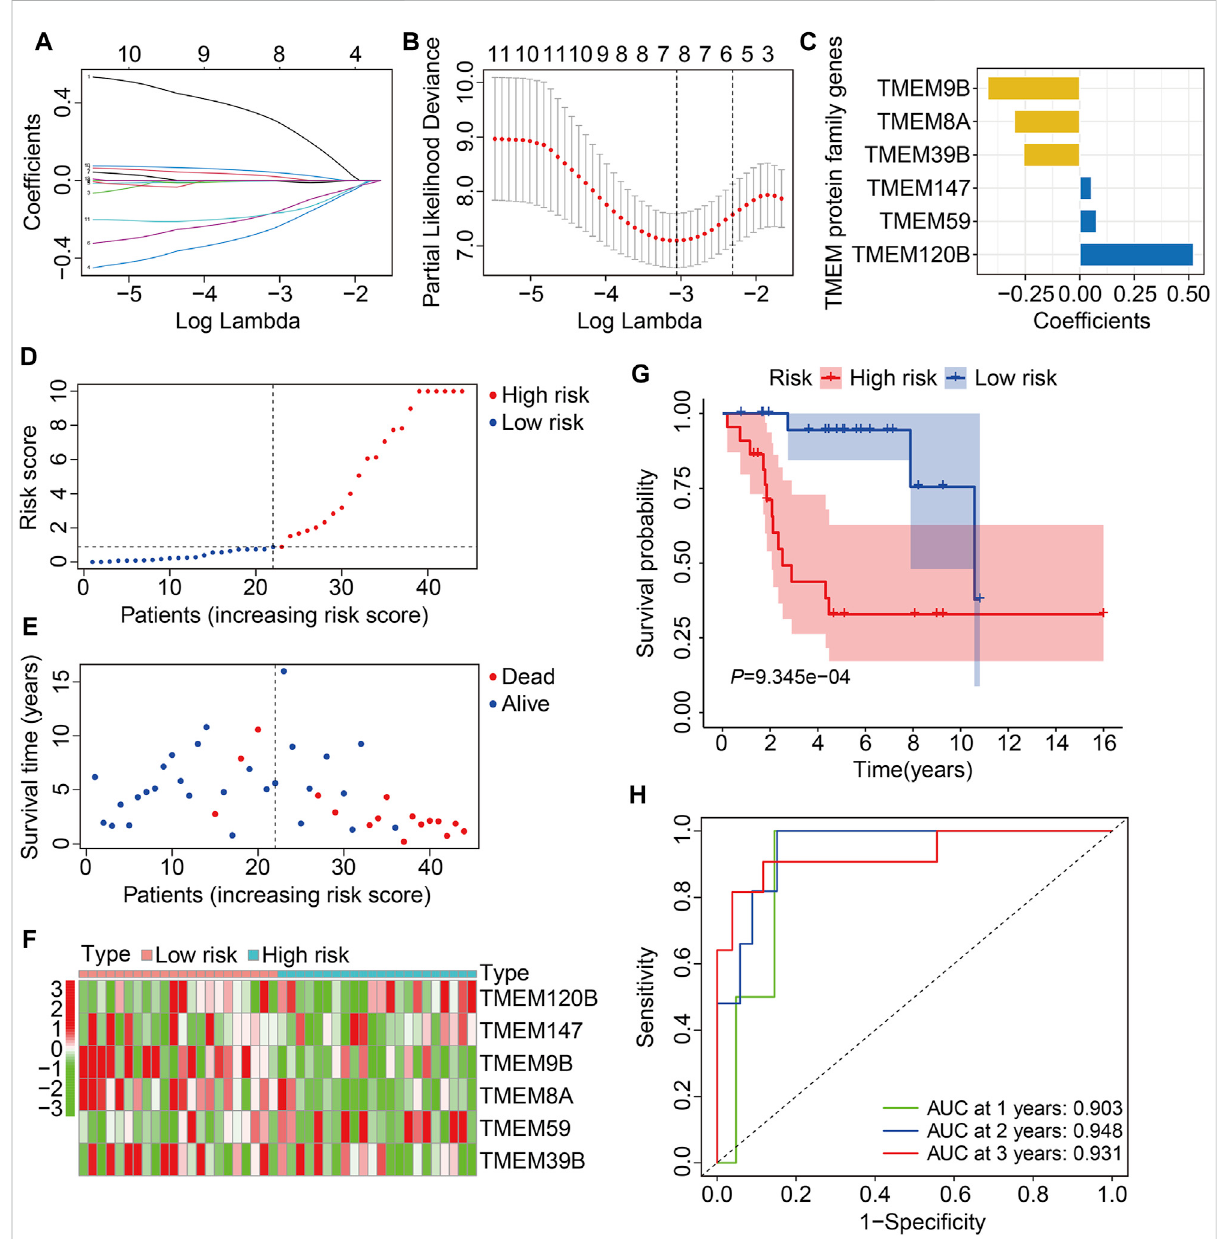
FIGURE 2 Construction of a TMEM protein family gene-based signature in osteosarcoma. (A,B) LASSO regression and multivariate Cox regression analyses. (C) The regression coef fi cients of the six TMEM protein family genes. (D,E) The distribution of risk scores and survival status of patients in TheCancerGenomeAtlas(TCGA)trainingcohort. (F) Theheatmapshowstheexpressionpro fi lesofthesixgenesinthehigh-andlow-riskgroups. (G) Kaplan – Meier survival curve for overall survival in the high- and low-risk groups. (H) Time-dependent receiver operating characteristic (ROC) curve for 1-, 2-, and 3-year overall